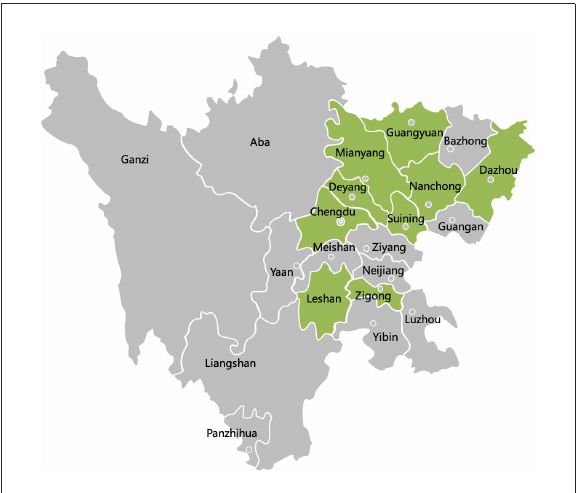
FIGURE1 The geographical distribution of 257 samples in Sichuan Province, China. Qionglai, Dayi, Pengzhou, and Jianyang are all parts of Chengdu. The cities with samples collected are marked with green